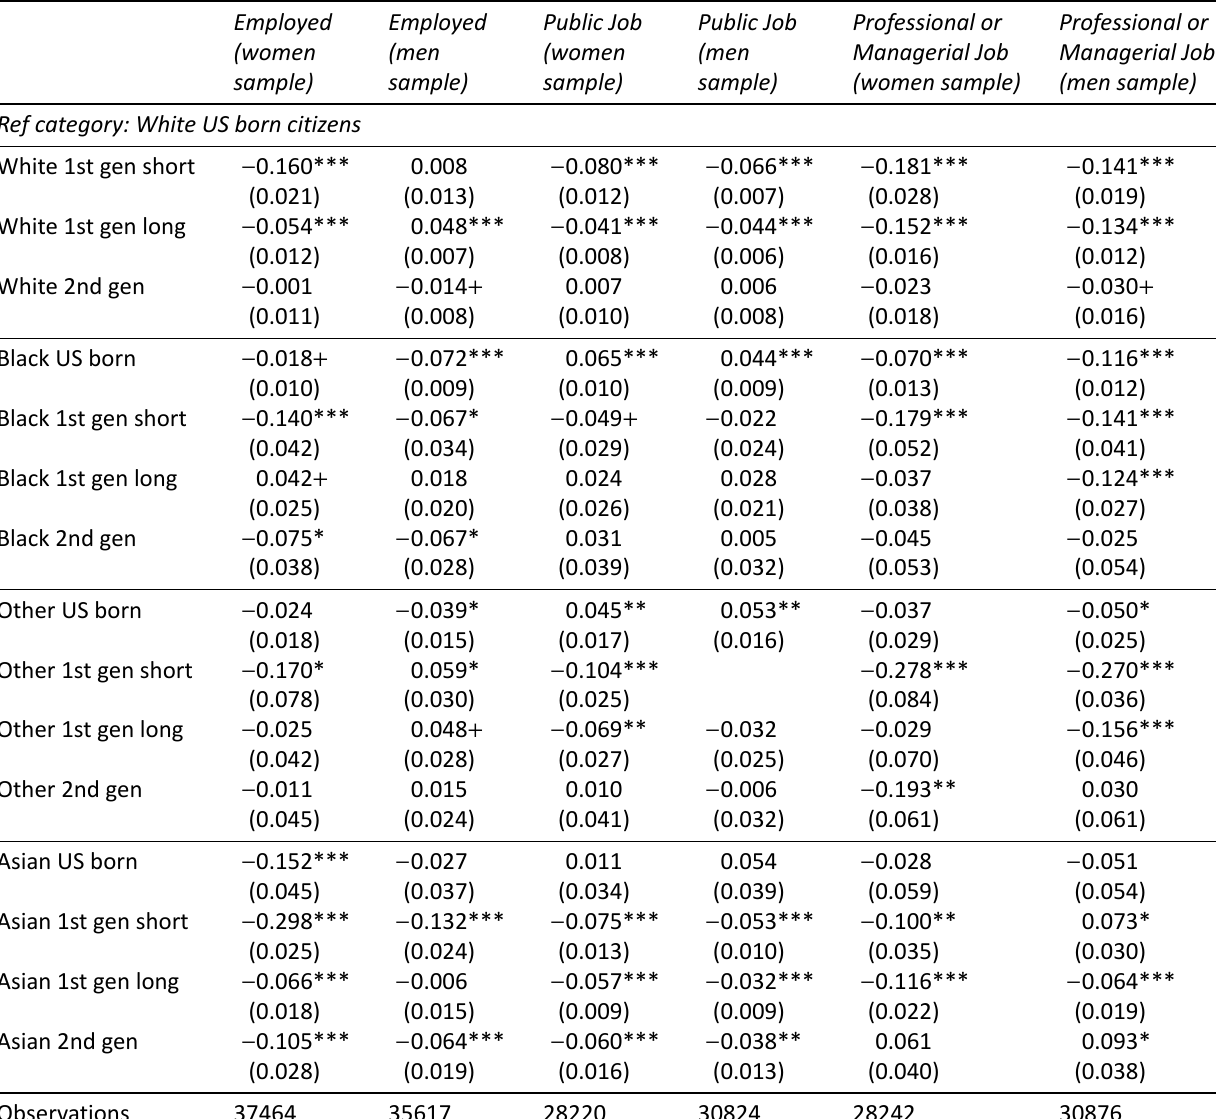
Table 2. Ethnic and migrant gaps with white majority in labour market outcomes. Source: US Census Bureau